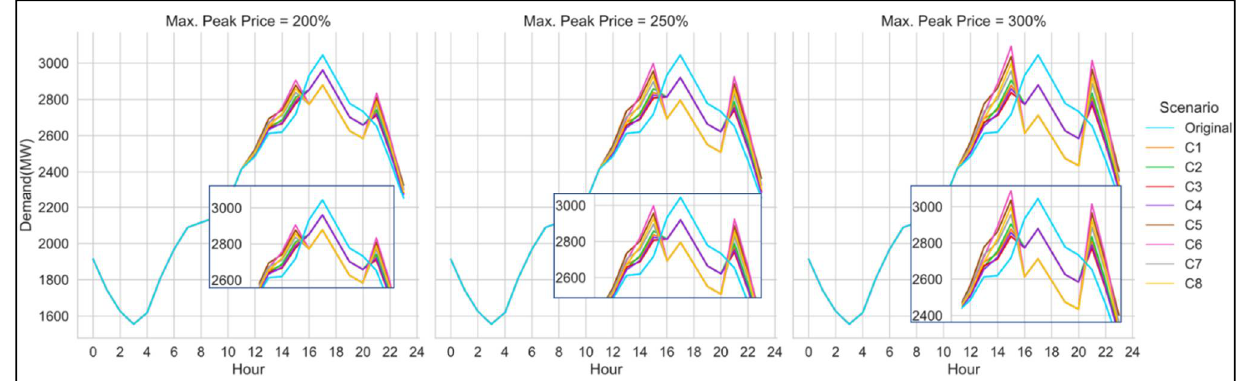
Figure 19. Hourly demand impact of DR-model under different case scenarios.